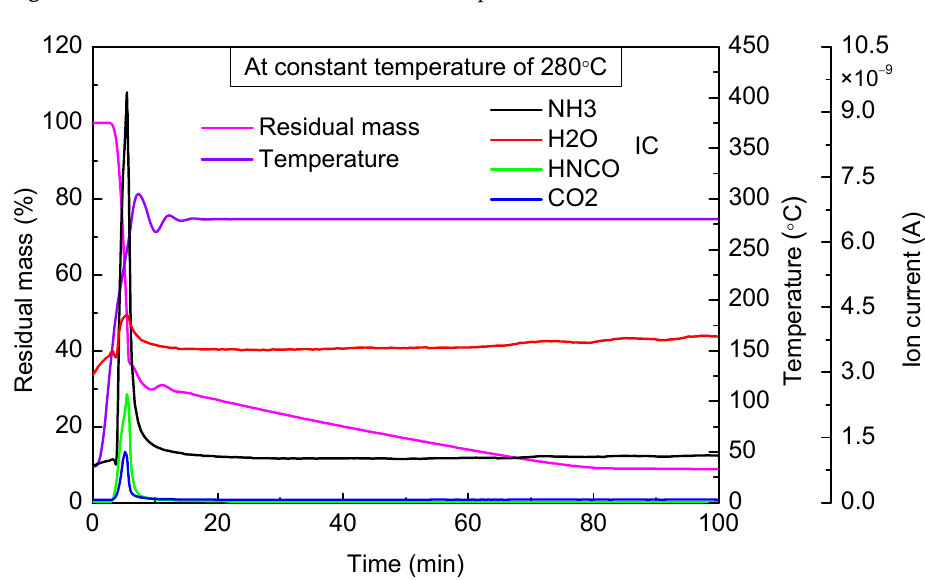
Figure 7. TG-MS results of urea at constant temperature of 280 °C.